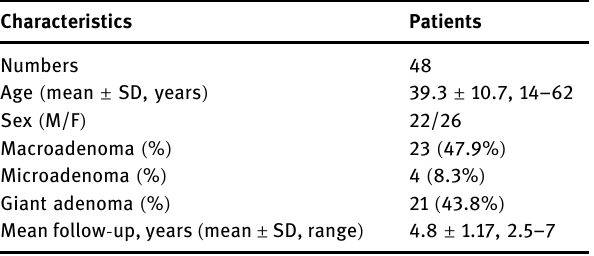
Table 1: Clinical and pathological characteristics of the patients